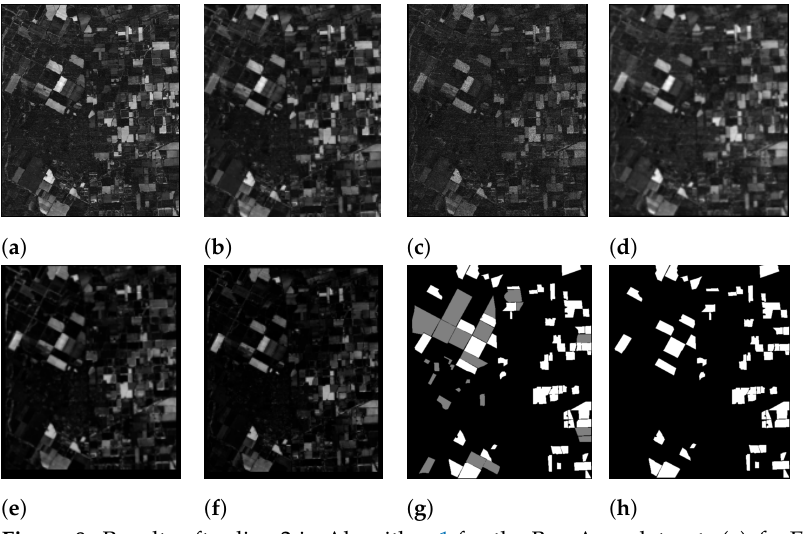
Figure 8. Results after line 2 in Algorithm 1 for the Bay Area dataset. ( a ) f 1 : Euclidean distance, ( b ) f 2 : Manhattan distance, ( c ) f 3 : SAM-ZID, ( d ) f 4 : SAM-MEAN, ( e ) f 5 : SMSADM, ( f ) f 6 : Pearson cc, ( g ) ground truth with unlabelled pixels in gray, ( h ) ground truth with only labelled